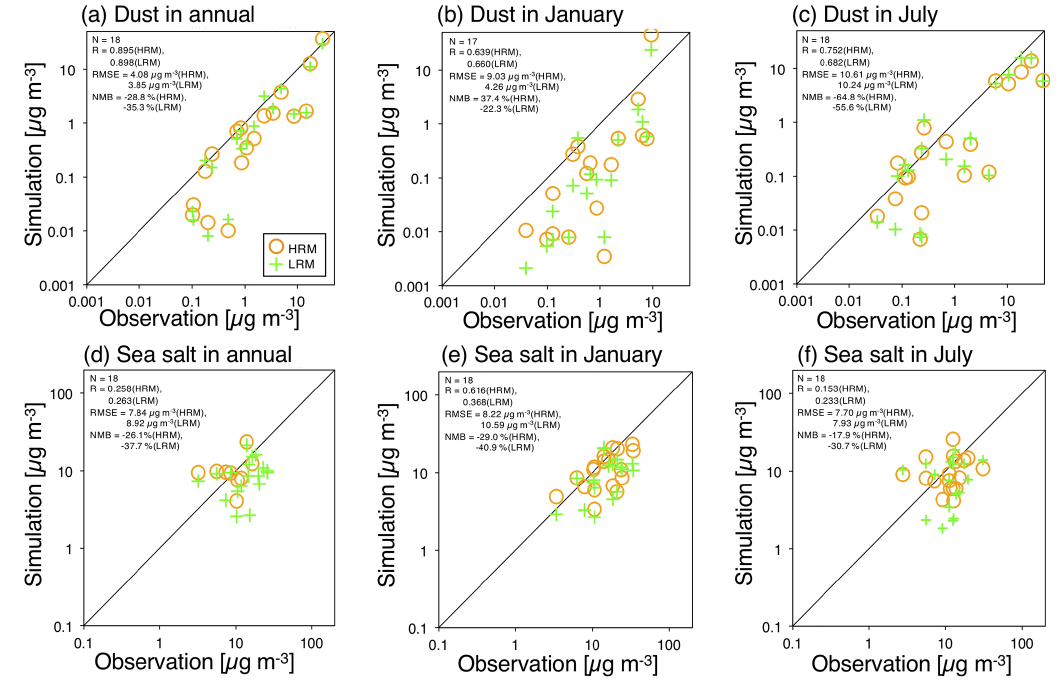
Figure 9. Scatterplots of the surface aerosol mass concentrations (dust and sea salt) between the measurements (the network managed by the University of Miami) and NICAM simulations (HRM in orange and LRM in green) for the annual, January and July averages. All units are in µgm − 3 . The numbers located in the upper-left corner in each panel represent the statistical metrics: N , PCC, RMSE and NMB. The statistical metrics are also shown in Tables S7 and S8. The sites employed for the comparison are shown in Fig.